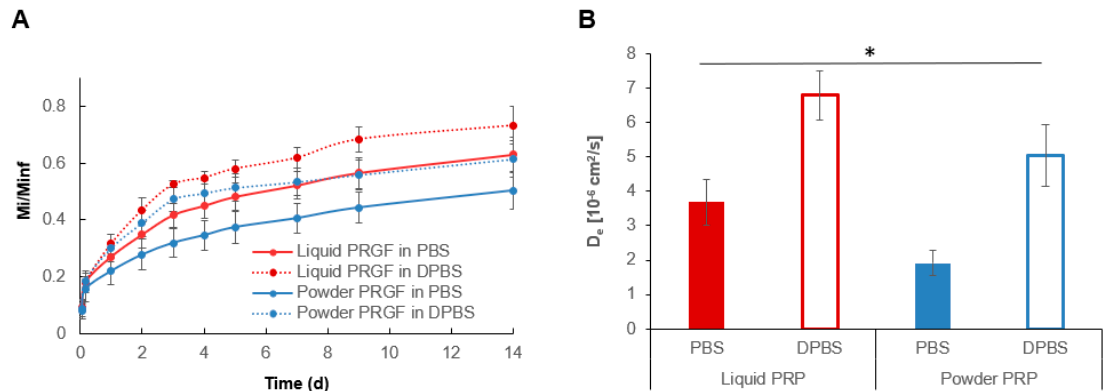
Figure 10. Release of powder and liquid PRP from PEG microspheres. ( A ) Normalized release profiles of powder PRP and liquid PRP-loaded microspheres. Both PBS and DPBS were used as release buffers where DPBS prevented clotting of PRP upon release. ( B ) Calculated effective diffusion coefficient for PRP release from powder PRP and liquid PRP-loaded microspheres in PBS and DPBS buffers. * denotes significant difference between all groups (n = 6; p < 0.05).